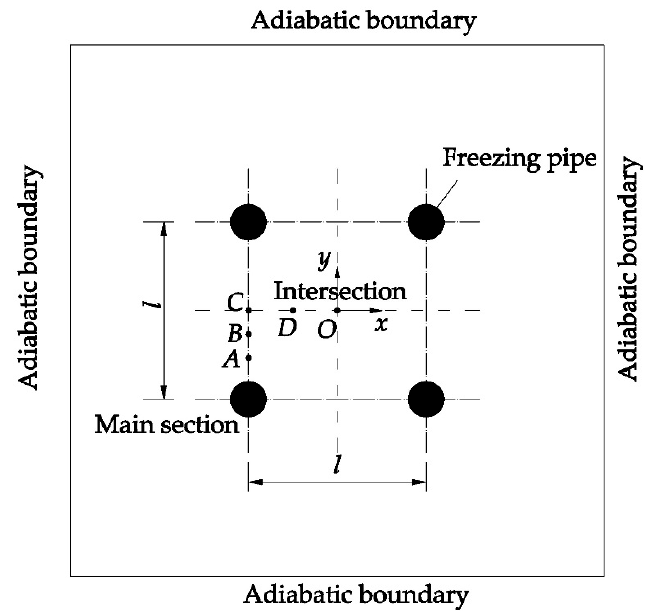
Figure 6. Schematic diagram of the calculation model.